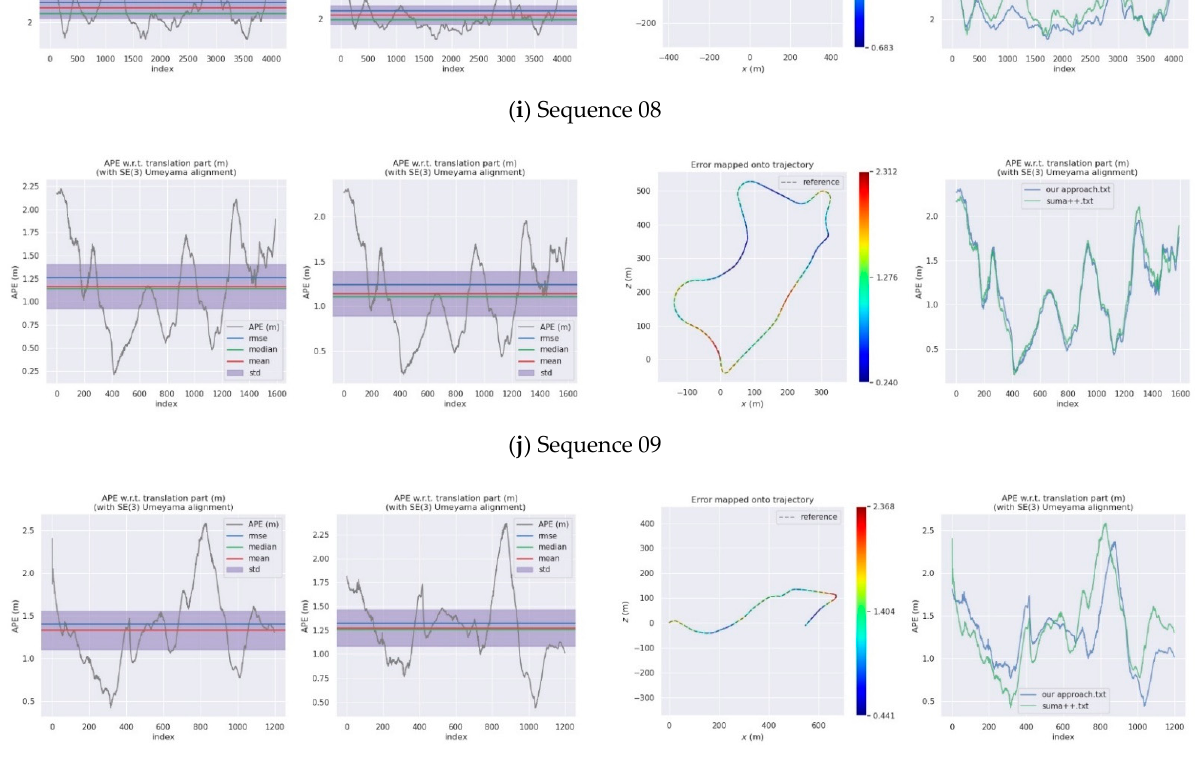
Figure 10. Experimental results of KITTI dataset.